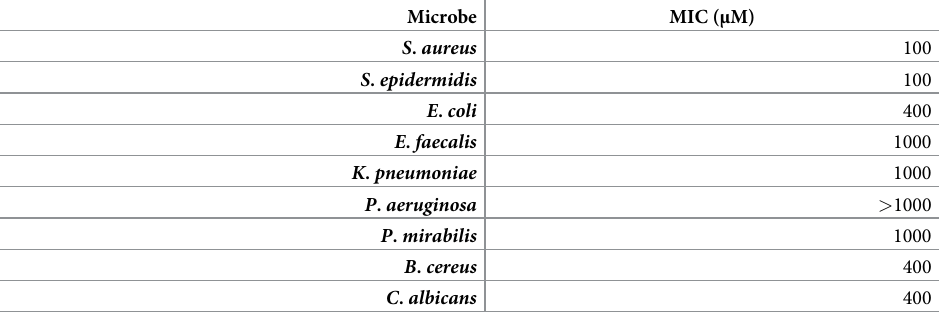
Table 1. MIC values obtained by serial dilution of compound 16b on a solid agar.